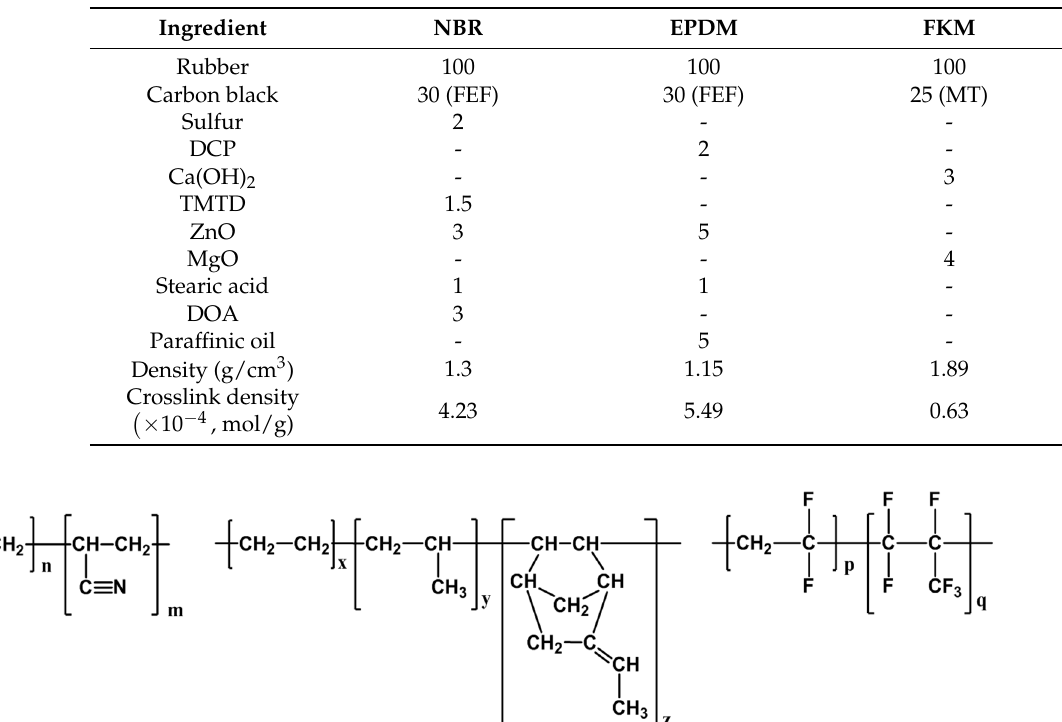
Table 1. Formulation of NBR, EPDM, and FKM (phr).